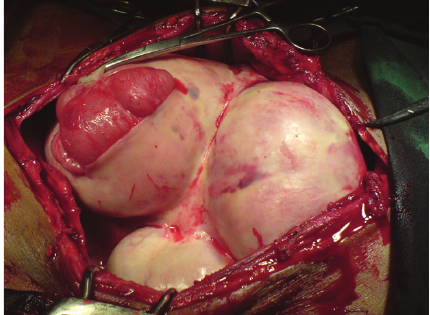
Figure 1: Three large cocoons enclosing the whole of the abdominal contents.